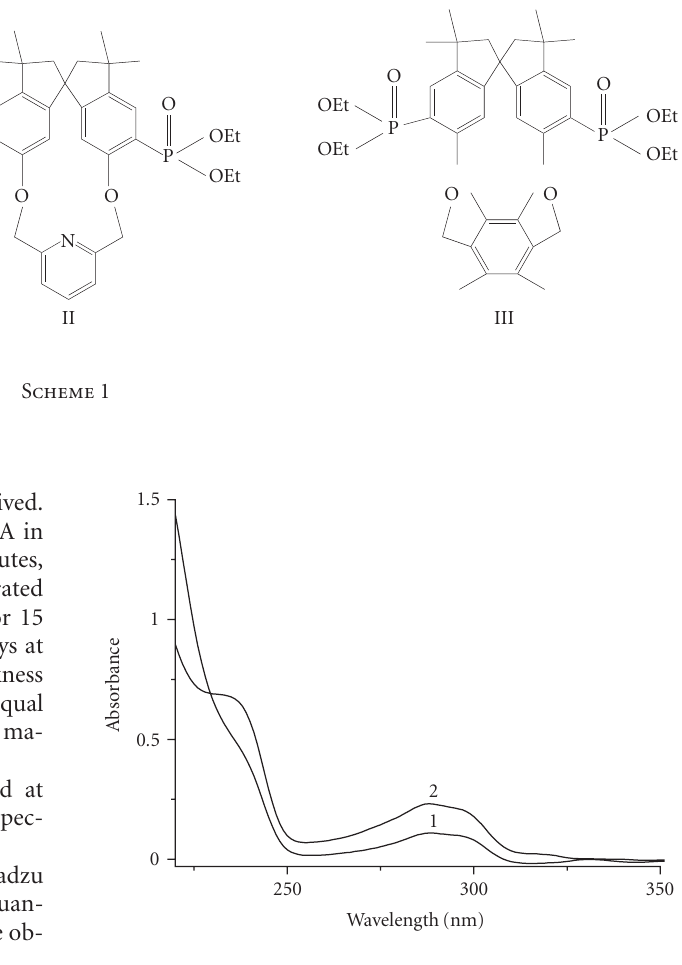
10 (cid:0) 5 M of (II) in methanol (cid:0) 10 (cid:0) 5 M of Eu 3+ (cid:0)